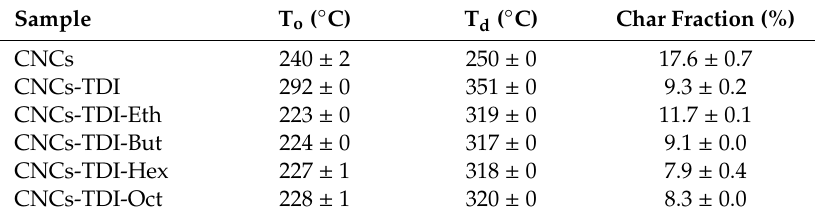
Figure 4. Thermogravimetric analysis (TGA) and DTG results of the CNCs before and after surface modification showing the significant change in thermal stability. Table 2. The thermal stability of the CNCs before and after surface